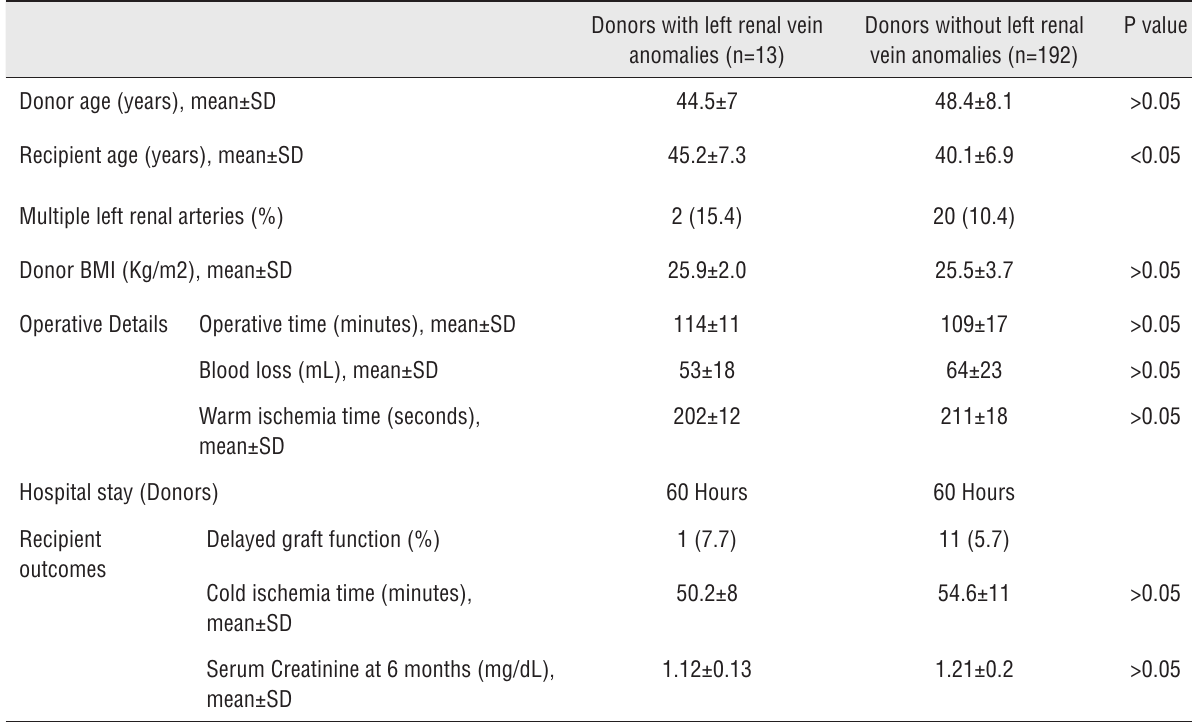
Table 3 - comparison of demographics and outcomes in patients with and without left renal vein anomaly.